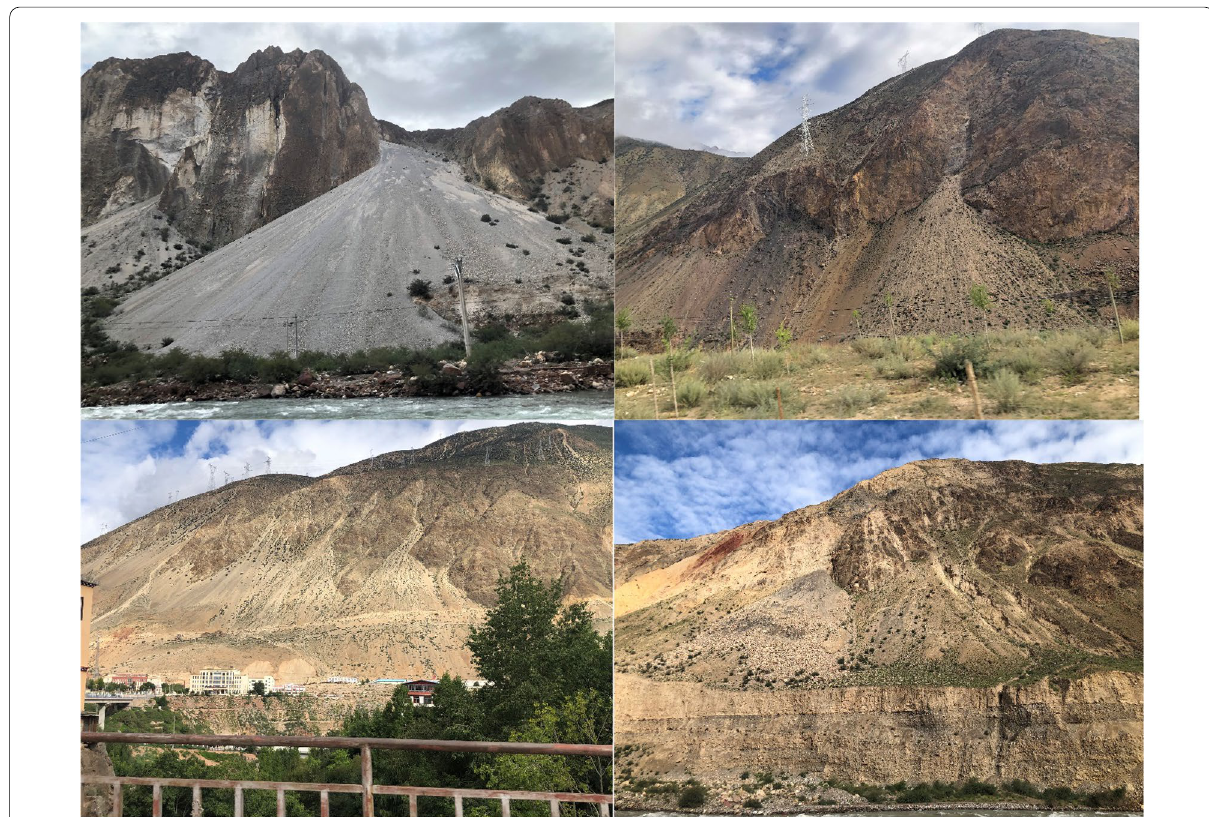
Fig. 2 Photographs of debris flows in the the study area (upper left: 29° 59 ′ 15.81 ″ N, 97° 10 ′ 55.78 ″ E; Upper right: 30° 3 ′ 37.09 ″ N, 96° 54 ′ 50.61 ″ E; Lower left: 30° 2 ′ 20.89 ″ N, 96° 45 ′ 10.50 ″ E; Lower right: 30° N, 1 ′ 38.77 ″ 32.90 ″ 7 ′ 97°